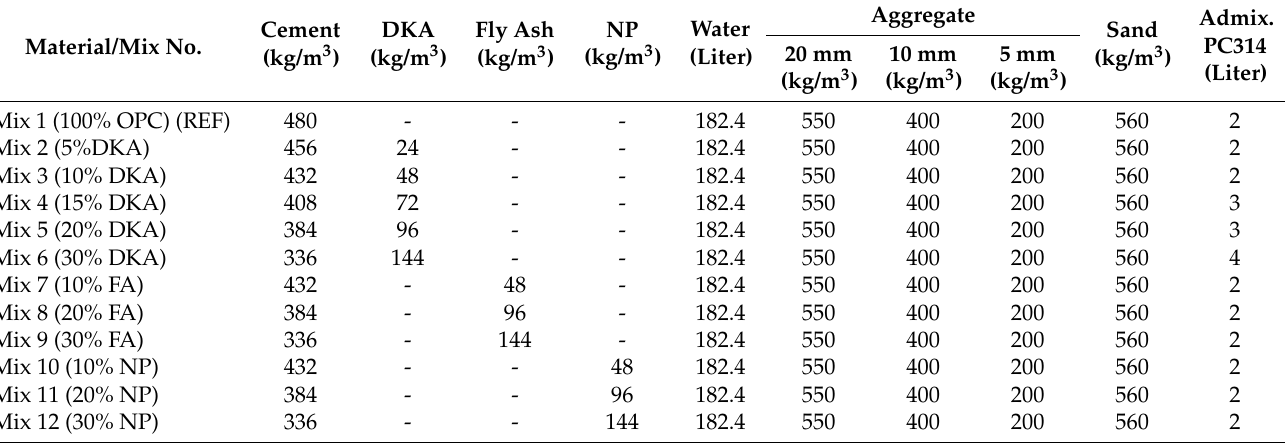
Table 3. Concrete mix proportions.